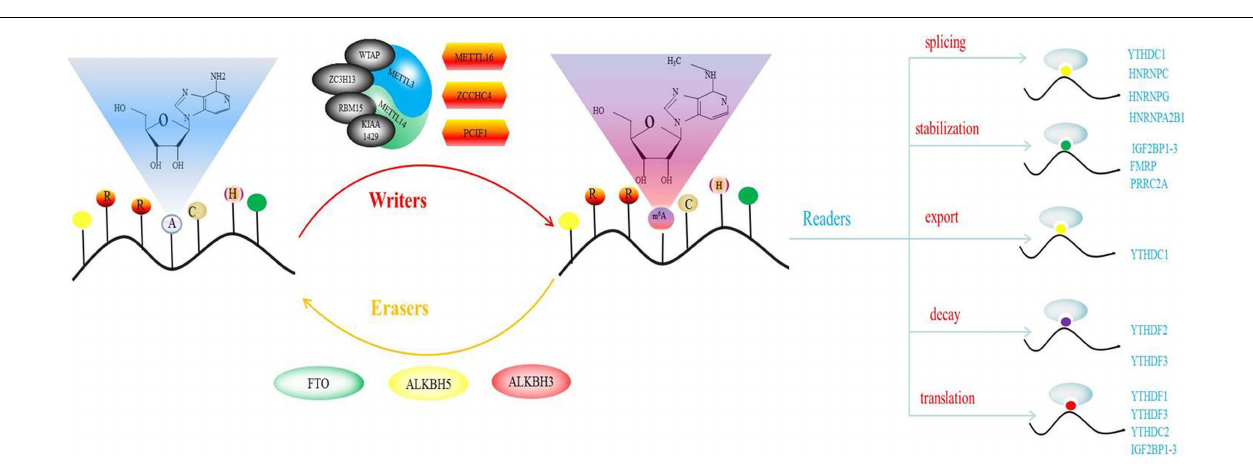
FIGURE 4 | Schematic illustration of m 6